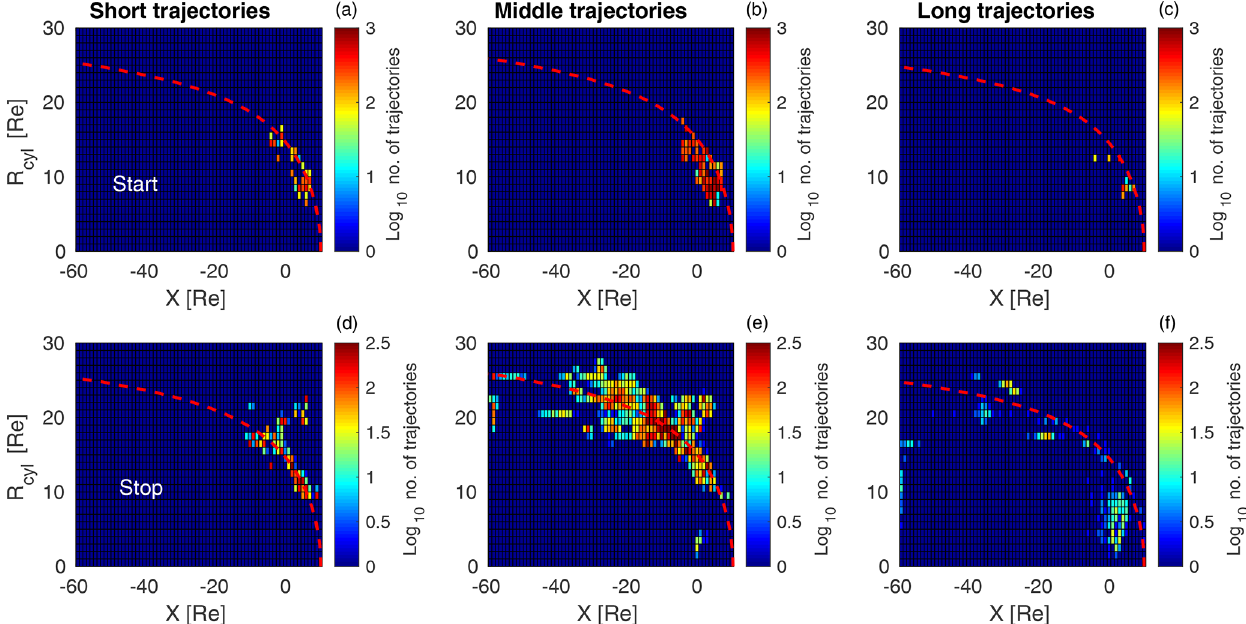
Figure 6. Cylindrical coordinates of the starting and ending positions of the launched O + ions depending on the length of their trajectory (see definitions in the text). Panels a – c show the starting positions, while the panels d – f show the ending positions. The colour bar represents the number of trajectories in each bin. The red dashed line shows the average magnetopause for the corresponding events.